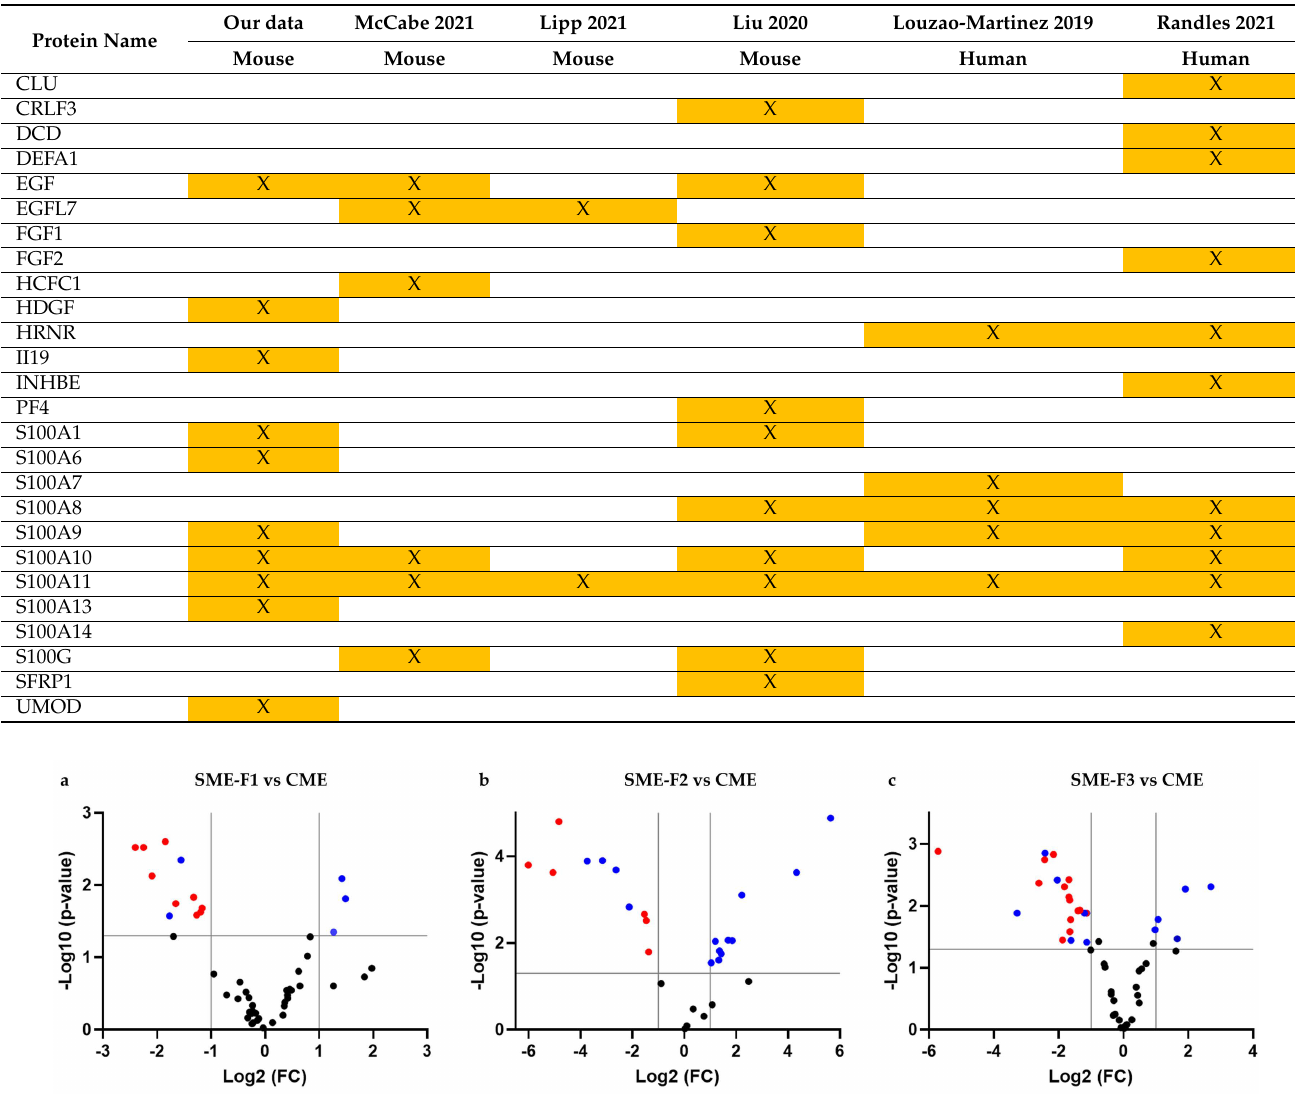
Table A15. The combined list of matrisome-associated proteins belonging to the category of secreted factors and identified in mouse and human kidneys. The mouse matrisome proteins were obtained from our data and extracted from references [20,28,30]. Human matrisome proteins were obtained from the studies [31,32]. Highlighted “X” refers to identified protein in the corresponding study.